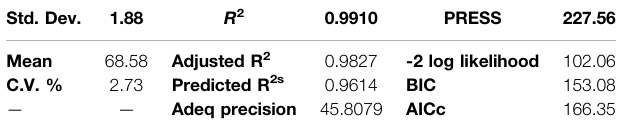
TABLE 8 | Parametric contribution percentage and optimum values for FFA